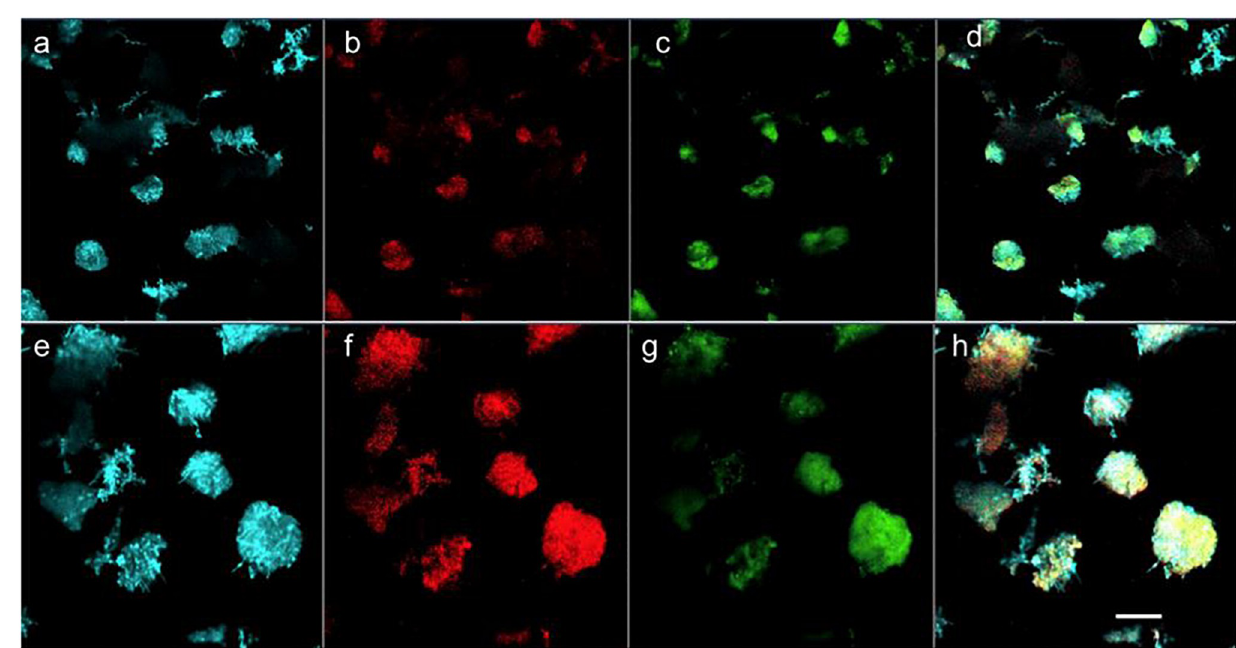
Fig 5. Confocal laser scanning microscopy images of LS IF SBR biomass, illustrating the distribution of EPS in flocs (a, d) before sloughing and, (e- h) following sloughing. Colors correspond to exopolymers with β structures (cyan), α -polysaccharide (red), and protein (green). Scale = 200 μ m.